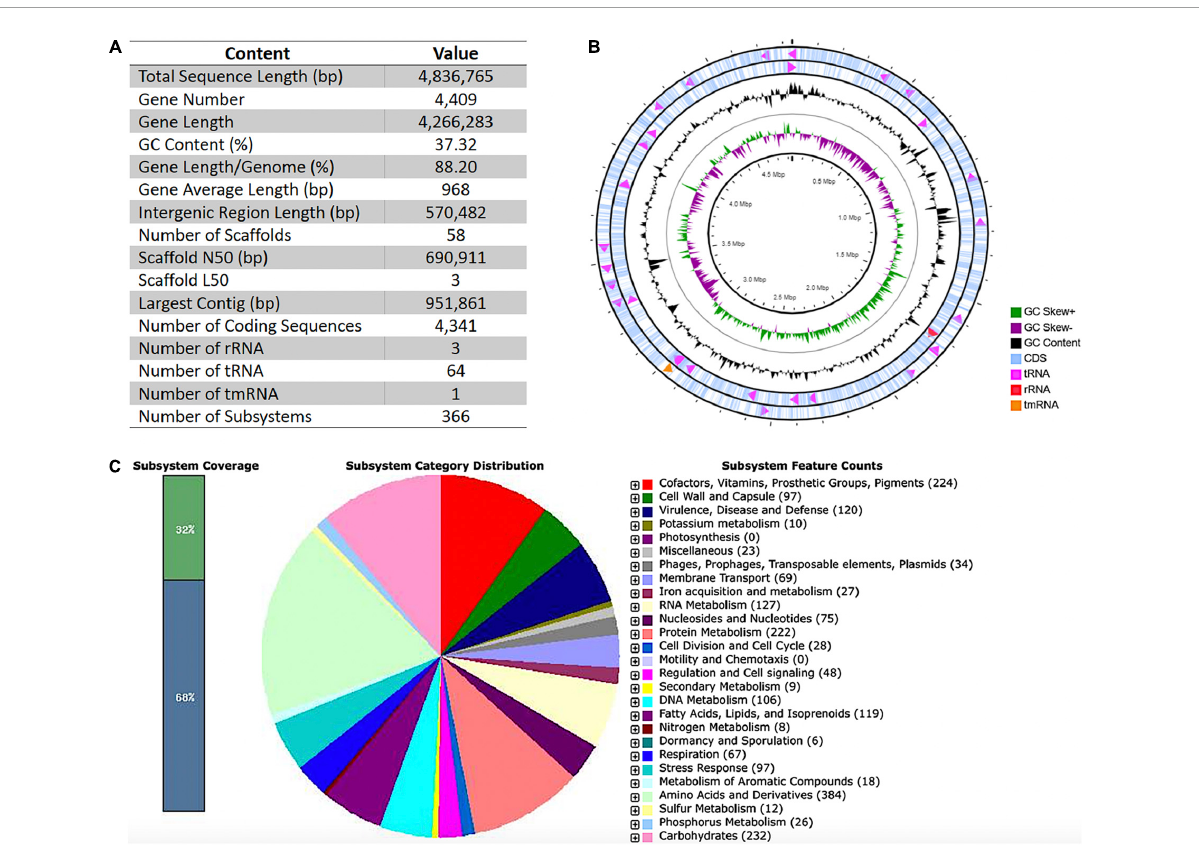
FIGURE1 Basic data of Whole-Genome Sequencing, circular representations, and subsystem category distributions of Chryseobacterium indologenes . (A) Assembly and annotation statistics. (B) Circles are numbered from 1 (outer) to 4 (inner). The outer two circles represent the coding sequence (CDS), transfer ribonucleic acid (tRNA), ribosomal ribonucleic acid (rRNA), and transfer-messenger RNA (tmRNA). The third circle shows the GC content (black). The fourth circle demonstrates the GC skew curve (positive GC skew, green; negative GC skew, violet). (C) The genome of C. indologenes annotated by the Rapid Annotation System Technology (RAST) server was classified into subsystems and categories. The green part in the bar chart at the leftmost position corresponds to the percentage of proteins included. The pie chart and count of the subsystem features in the right panel show the percentage distribution and category of the